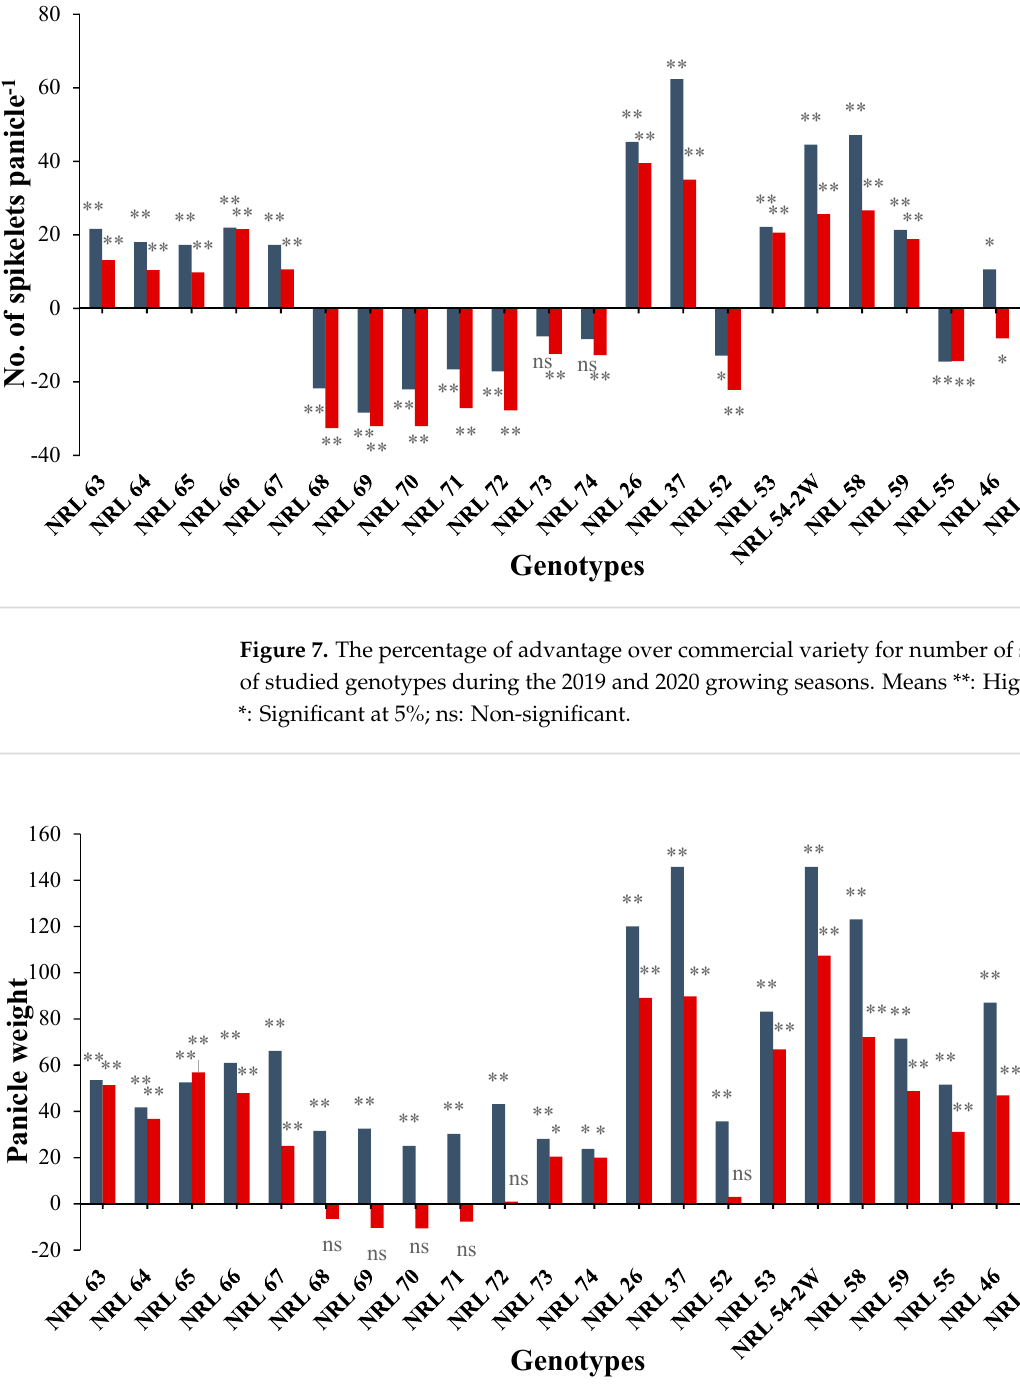
Figure 9. The percentage of advantage over commercial variety for 1000-grain weight of studied genotypes during the 2019 and 2020 growing seasons. Means **: Highly significant at 1%; *: Signifi- cant at 5%; ns: Non-significant.